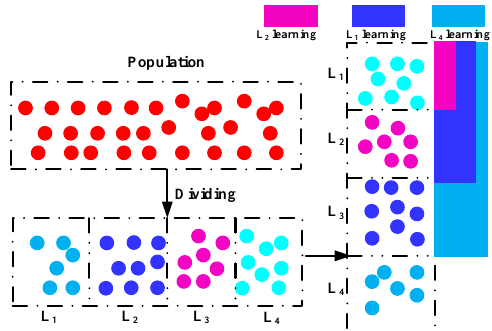
Figure 1. Framework of level-based learning